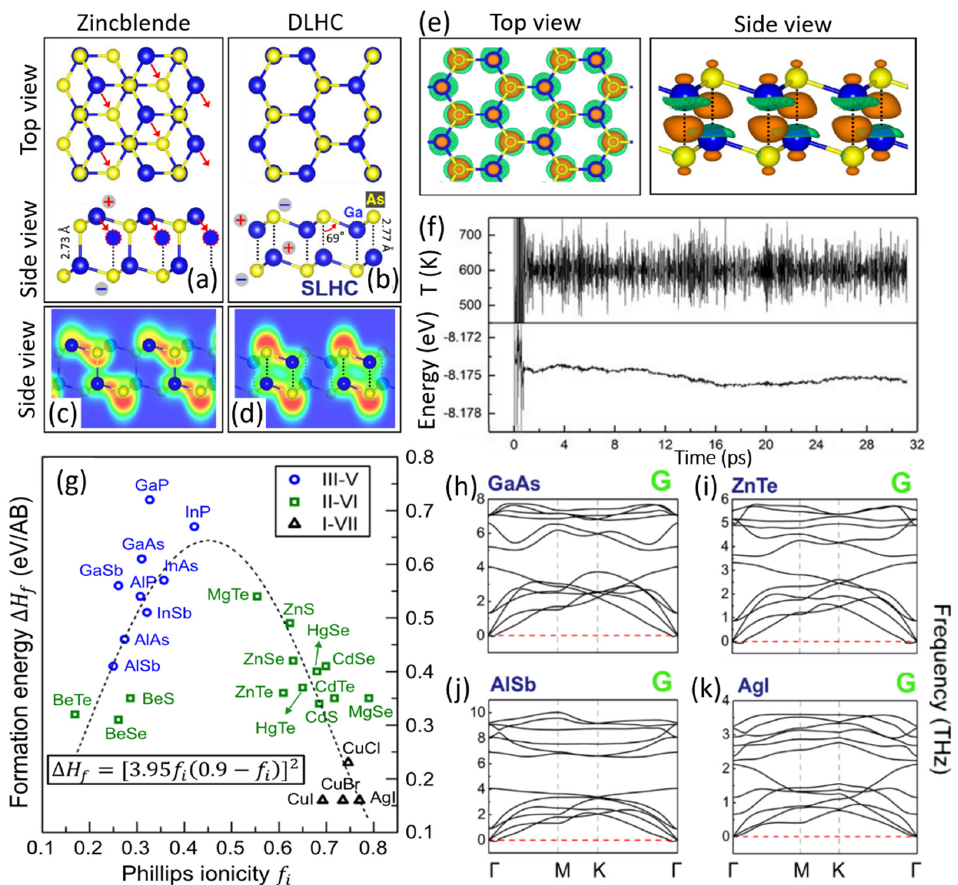
Figure 1. Top and side views of ( a ) a bilayer-thick monolayer truncated bulk GaAs and ( b ) a DLHC GaAs. The red arrows in ( a ) indicate atomic displacements that turn truncated bulk to DLHC. Electron localization functions of ( c ) the truncated bulk GaAs and ( d ) the DLHC GaAs with contour values ranging from 0 (blue) to 0.8 (red). ( e ) Charge density difference (CDD) between DLHC and SLHCs for GaAs with the brown being positive and green being negative. ( f ) The temperature and energy in an MD simulation of GaAs DLHC structure at T = 600 K for 31 ps. ( g ) Formation energy of different DLHC materials as a function of Phillips ionicity. The dotted line is a two-parameter least-squares fit of the data. ( h – k ) Phonon spectra of several selected DLHC structures, including group III–V (such as GaAs and AlSb), group II–VI (such as ZnTe), and group I–VII (such as AgI). Reproduced with permission [30]. Copyright 2018, American Physical